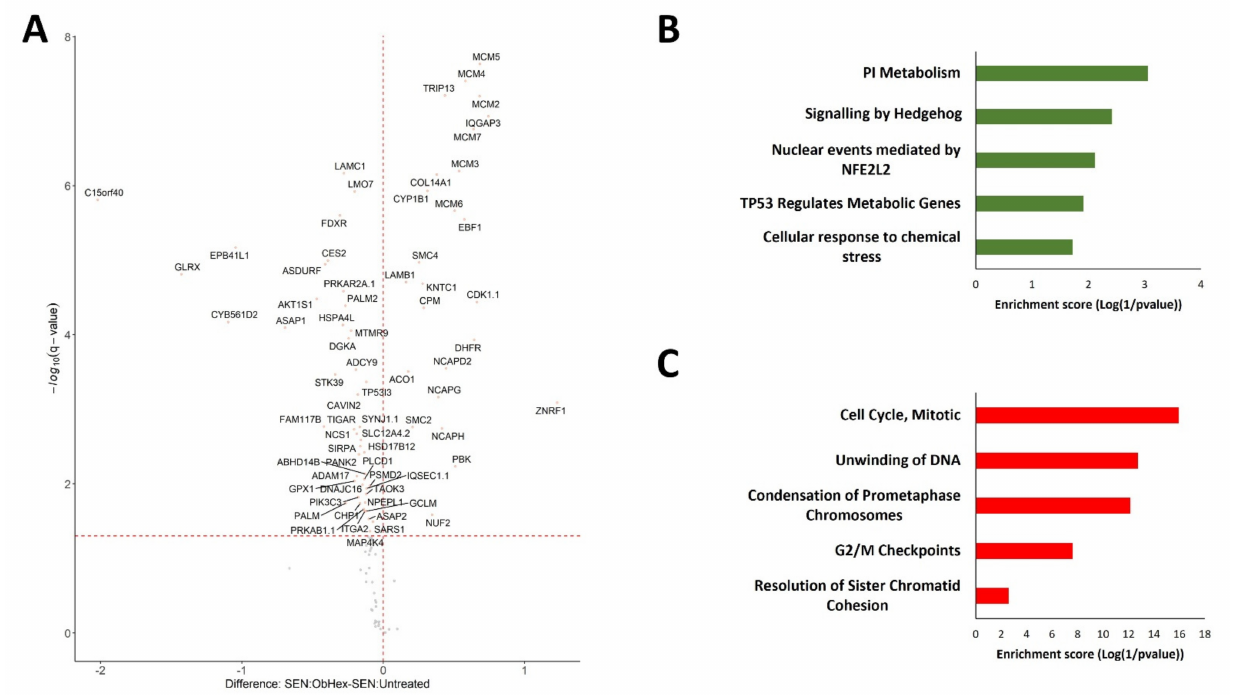
Figure 3. ( A ) Plot representing the statistical difference between senescent cells with the pres- ence or absence of ObHEx extract resulting from Tukey HSD post-hoc test of Two-way ANOVA interaction factors (i.e., Induction and Treatment). The abscissa reports the fold change in loga- rithmic scale (difference), and the ordinate − log ( q value) of the Tukey HSD tests for the specific SEN:ObHex/SEN:Untreated pairwise comparison while keeping the family-wise error rate low (family-wise confidence level of 0.95). ( B ) Reactome enrichment analysis of downregulated and ( C ) upregulated proteins in senescent NHDF cells after ObHEx treatment. Only the main five pathways have been reported ( p <